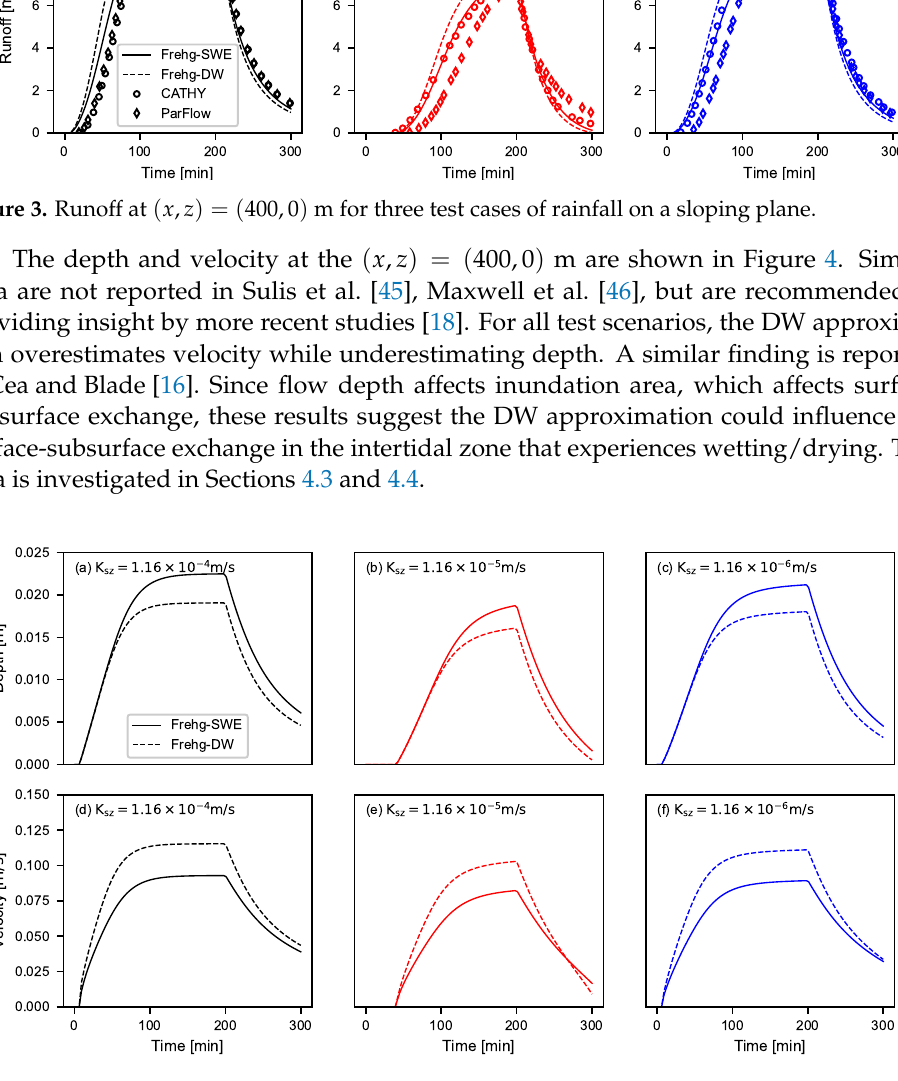
Figure 4. Depth and velocity at ( x , z ) = ( 400,0 ) m for three test cases of rainfall on a sloping plane. Figure 5 shows the numerical dimensionless numbers (Equations (18)–(20)) as func- tions of time. It can be seen that ˆ R f is close to 1 for all tested conductivity values. Further- more, ˆ Fr and ˆ Rt are orders of magnitudes smaller than ˆ R f . Because these non-dimensional numbers represent the relative importance of terms in the momentum equations (see Section 2), these results indicate that the pressure gradient and bottom friction are well- balanced and the inertia terms are relatively unimportant for this rainfall-runoff case.